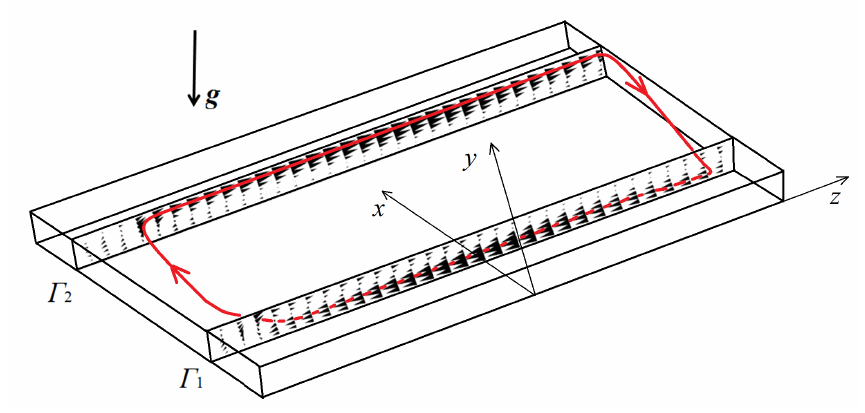
Figure 13. The velocity profiles calculated at time t = 50 s in two cross-sections x = 3 mm ( Γ 1 ) and x = 9 mm ( Γ 2 ). The inclination angle α = 70 ◦ . Maximum velocity found in the cross-sections Γ 1 and Γ 2 is 0.2 cm/s. The red line shows the trajectory of the main fluid